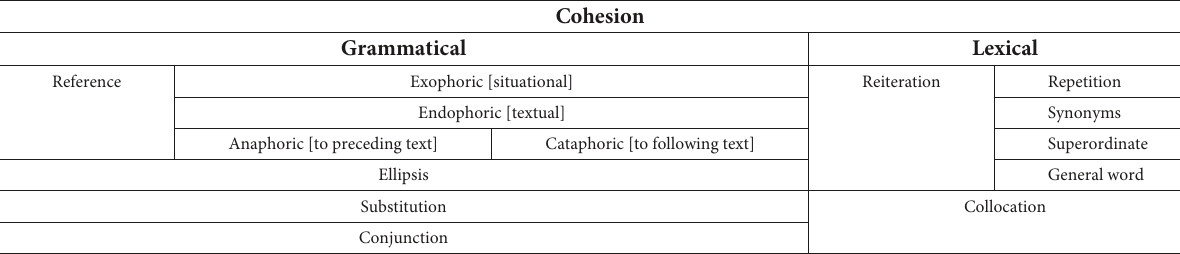
TABLE 1 Types of Cohesion based on Halliday and Hasan (1976) (Adapted from Tsareva, 2010, p.